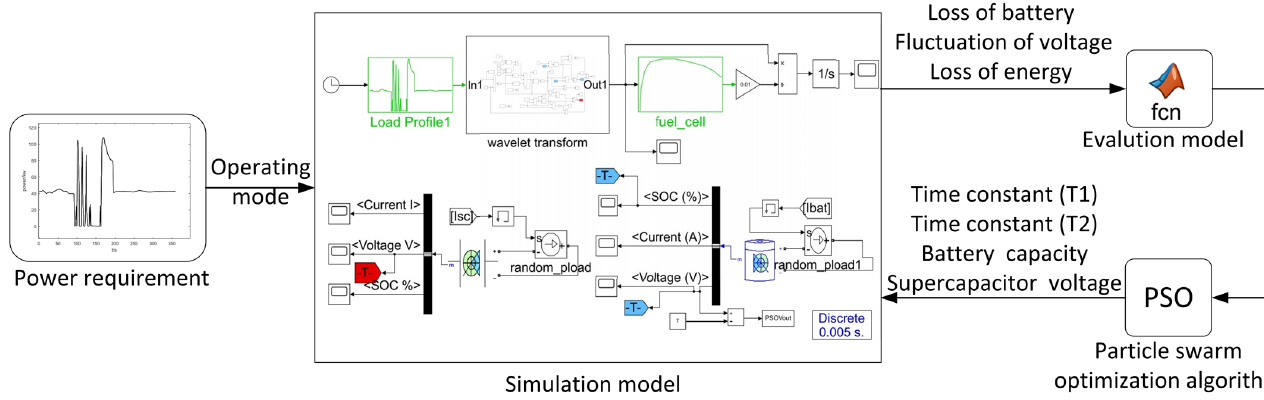
Figure 5. System optimization flowchart. Table 3. Parameter optimization results.